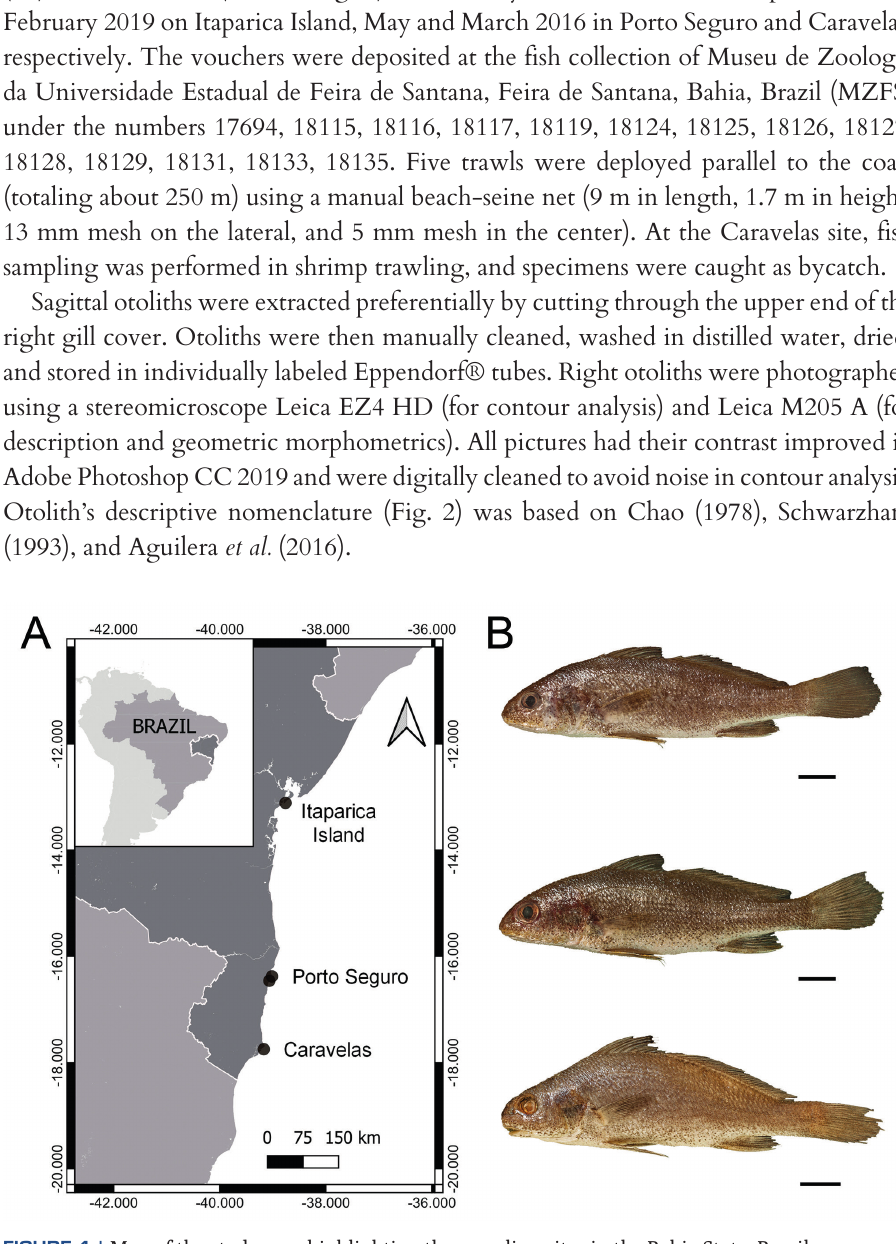
FIGURE 1 | Map of the study area highlighting the sampling sites in the Bahia State, Brazil. B. Representative specimens of the species studied. Stellifer gomezi (top); S. menezesi (middle); S. punctatissimus (bottom). Scale bars = 10